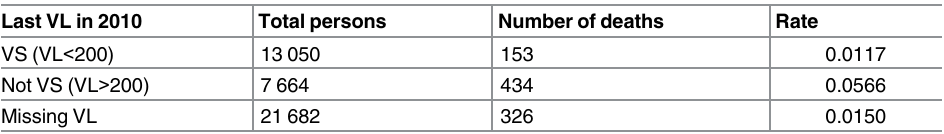
Table 1. Deaths by viral load category in 2010,